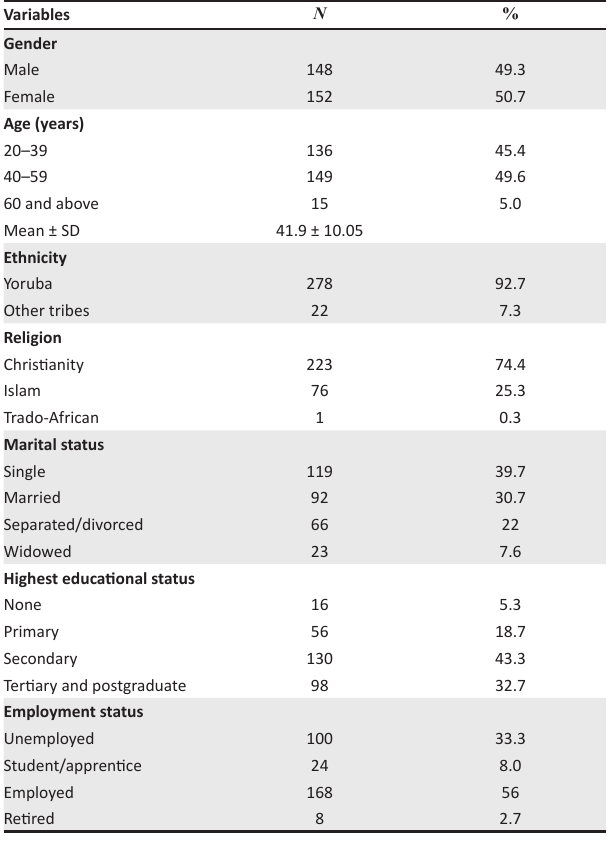
TABLE 1: The socio-demographic characteristics of the respondents. Variables